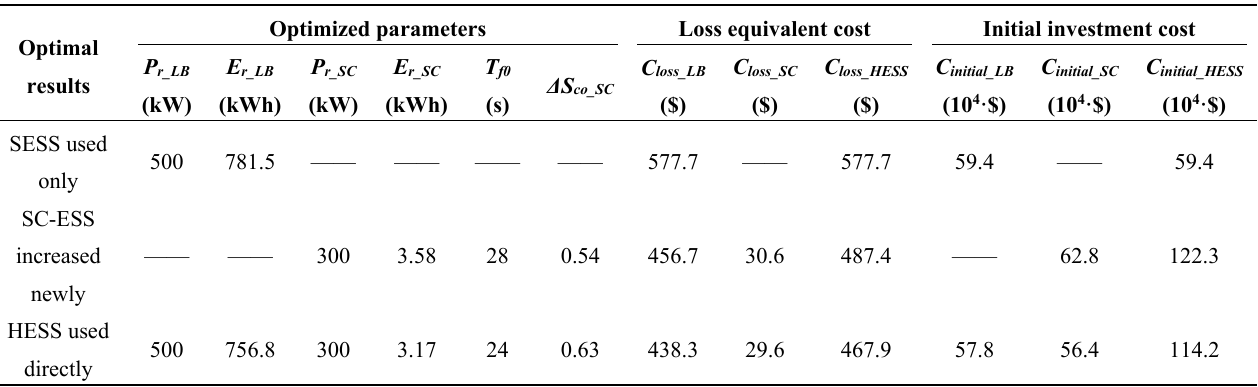
Table 5. Optimization results of ESSs in three